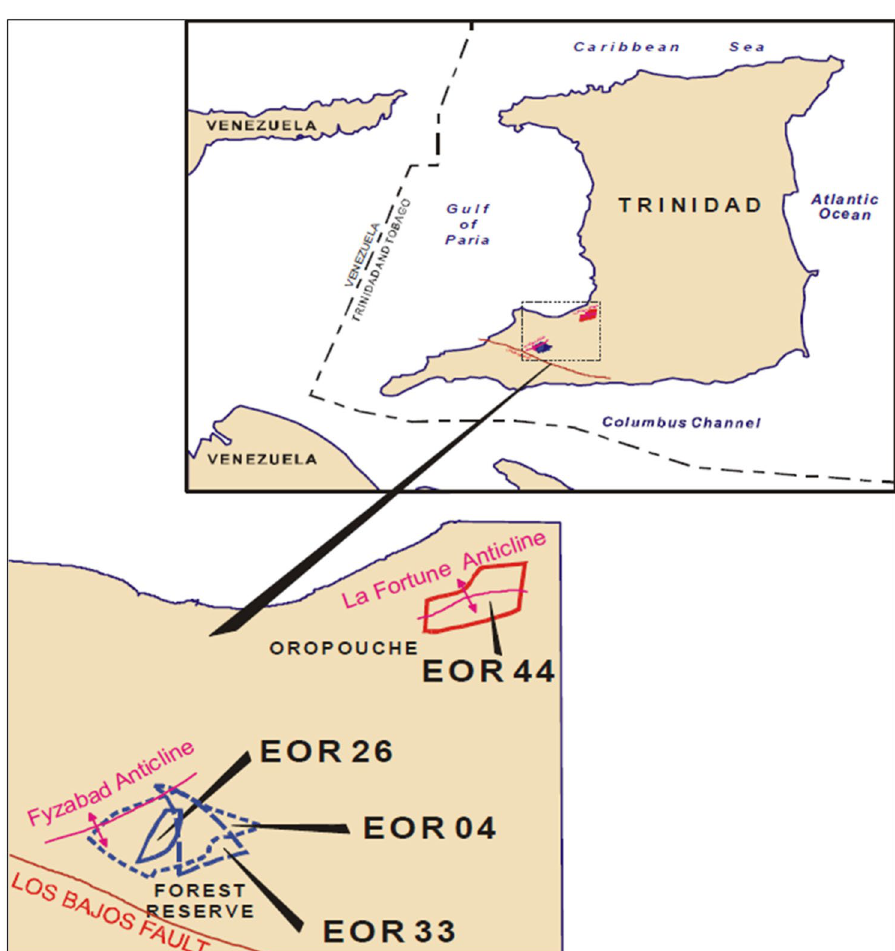
Fig. 8 Location of selected lower forest field EOR33 ( Source Mohammed-Singh and Singhal